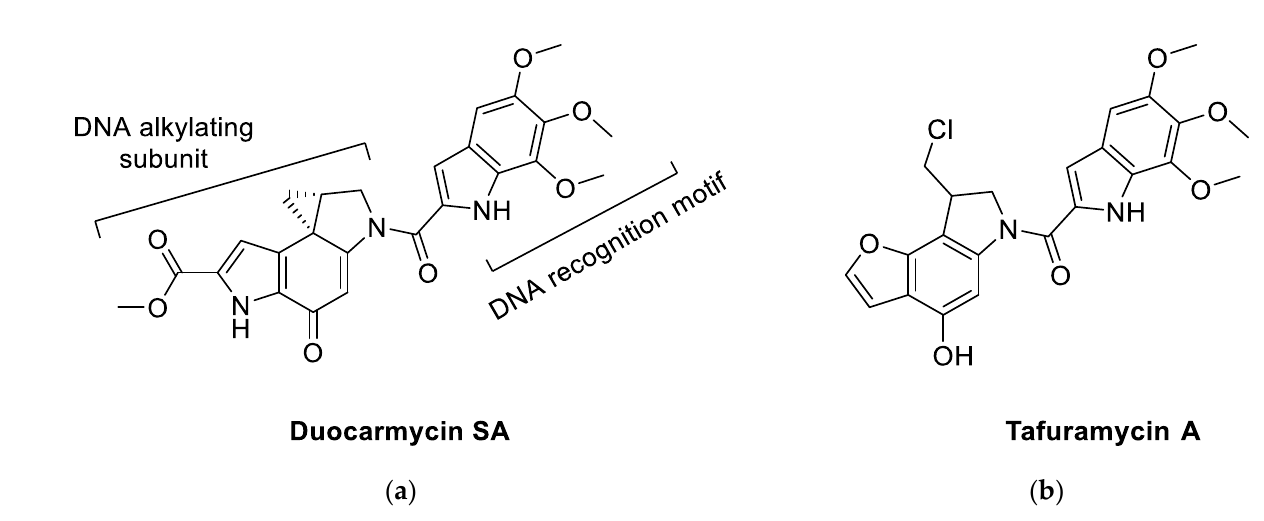
Figure 1. Chemical structure of ( a ) duocarmycin SA and ( b ) tafuramycin A.